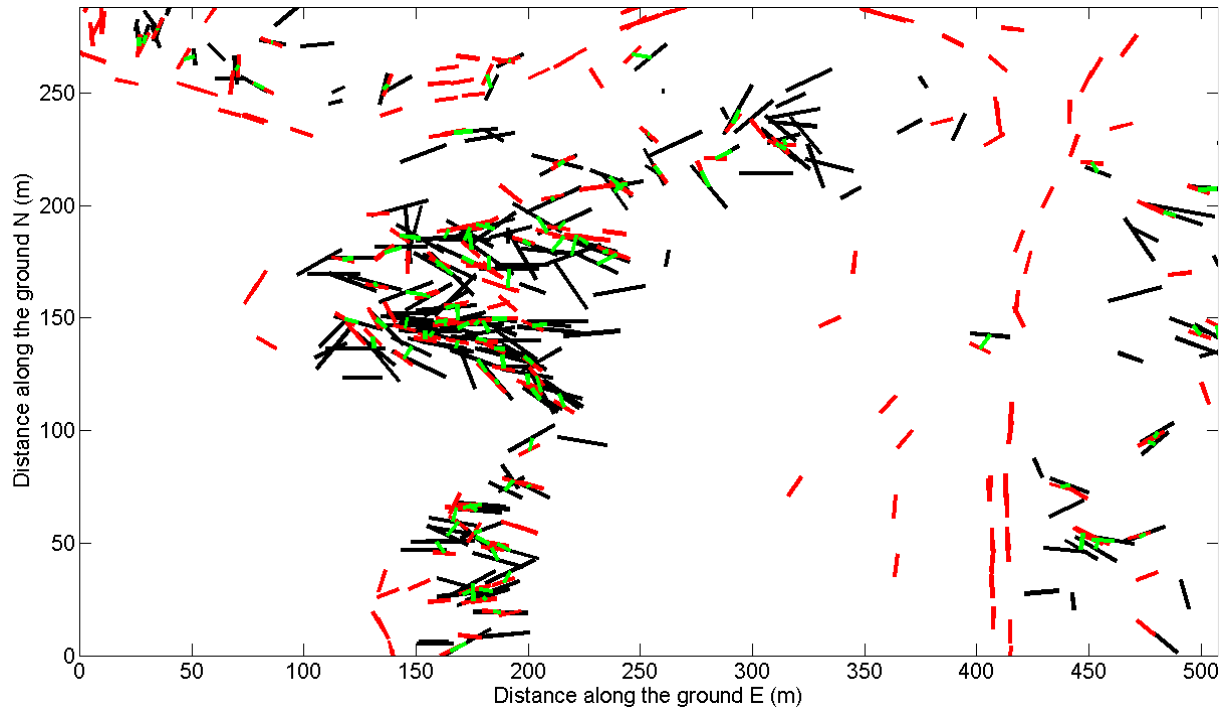
Figure 5. Field-measured stems (black), detected lines (red), and the links between them (green) inside the white box in Figure 1. Only stems and lines inside the inventory area are shown.